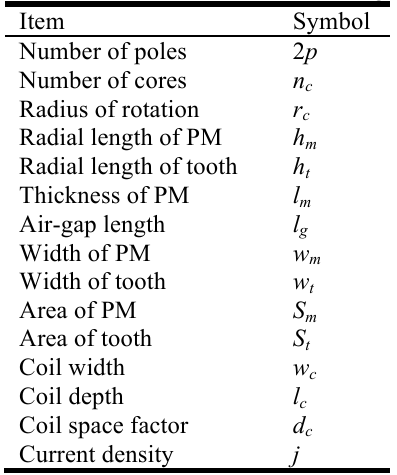
Figure 4: 1-magnet 1-tooth simple modeling. Table 1: Parameters used for